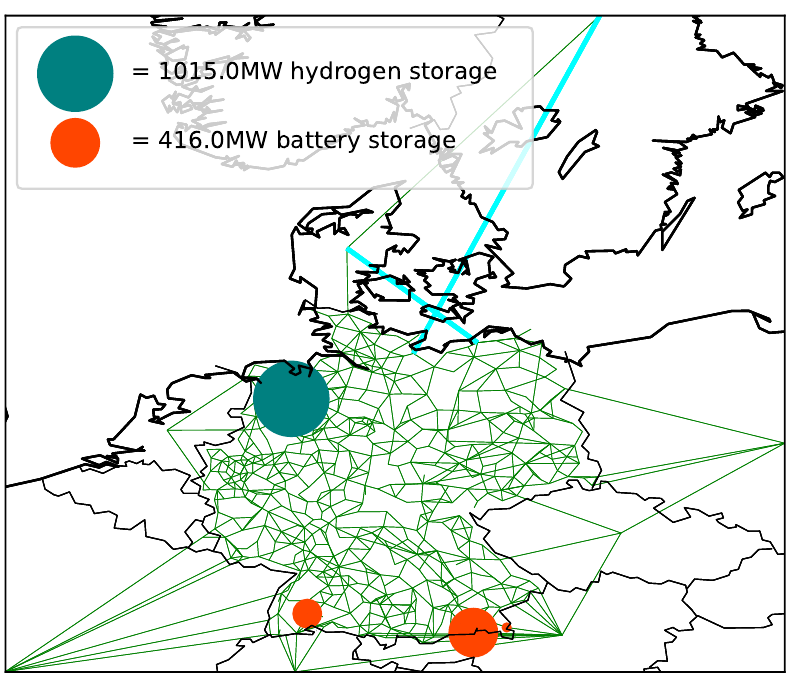
Figure 2. Spatial distribution of additional storage units. The size of a dot represents the storage capacity in MW. Blue dots show hydrogen storage units, red dots indicate battery storage units. Cross-border DC power lines are depicted in light blue.